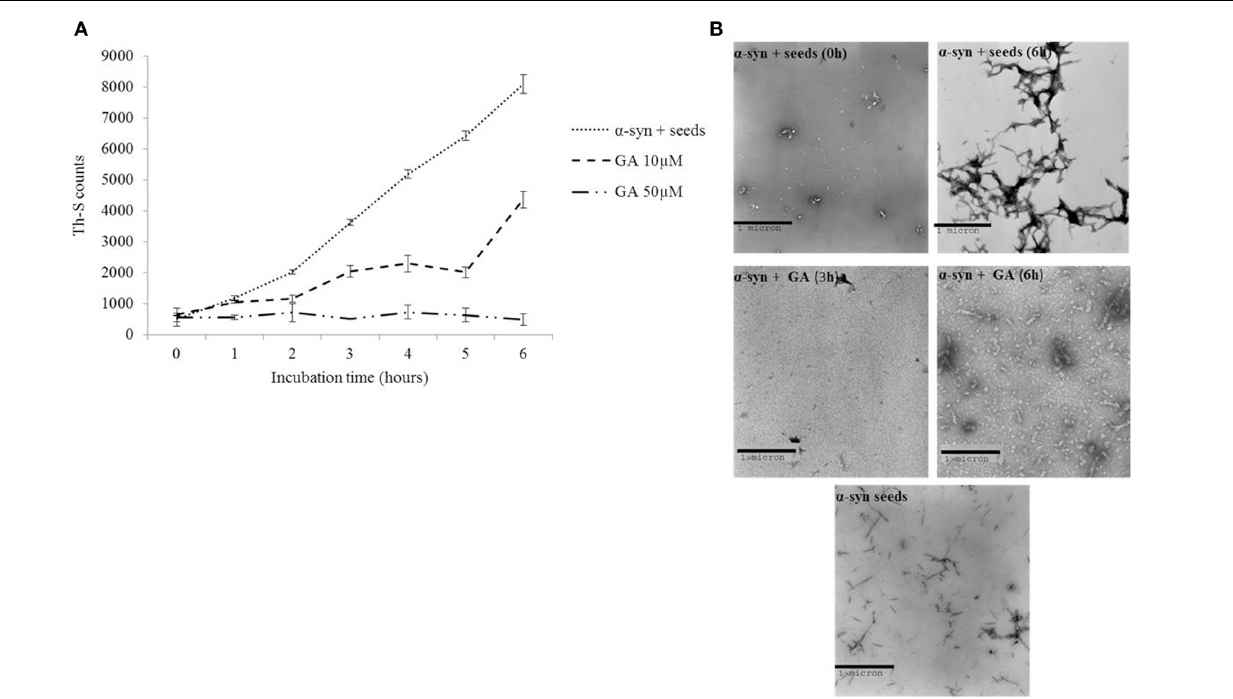
FIGURE 4 | GA inhibits the seeded fibrillation of α -syn. (A) Samples of α -syn (100 μ M) seeded with short fibrillar α -syn (2 μ M) were incubated in the presence or absence of GA at different concentrations (10–50 μ M) for 6h with continuous shaking at 37 ◦ C. The extent of fibrillation was estimated by the Th-S binding assay. The assays were